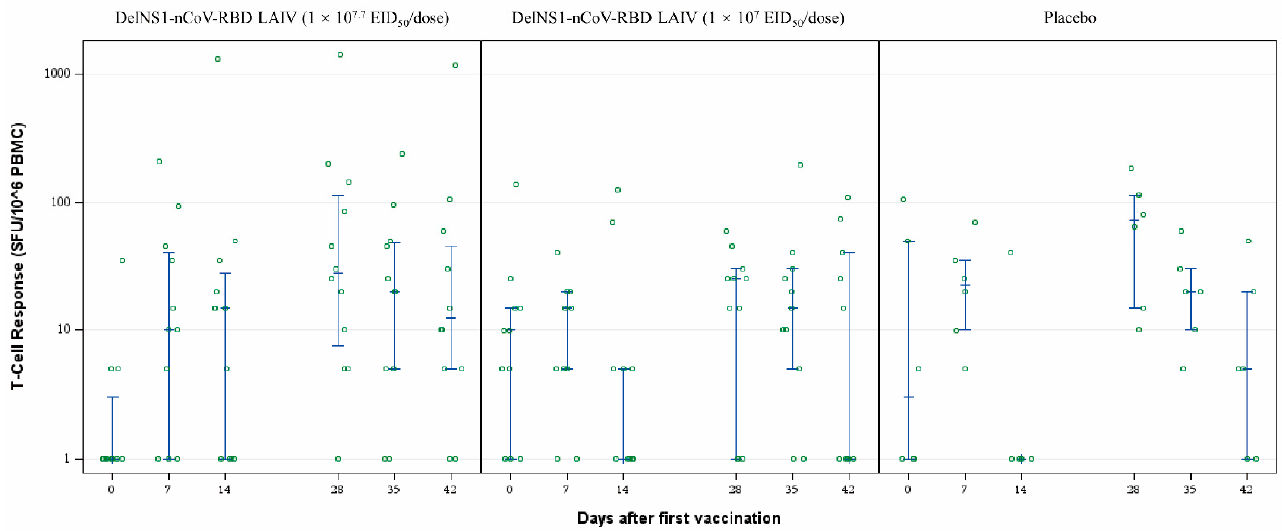
Figure 4. T-cell responses by ELISpot over time. Blood samples were taken from the subjects on baseline (day 0) and at 7, 14, 28, 35, and 42 days after the first dose of vaccine. Once separated from the blood, PBMC were seeded into anti-human IFN- γ antibody coated plate followed by the incubation with SARS-CoV-2 RBD peptide pool overnight. The substrate was added into the plate after cells incubated with Streptavidin-Alkaline Phosphatase (ALP). The spots in the plate were counted under an immunospot reader. One-way ANOVA was used to compare the T-cell response in the three groups. The error bars represent median with interquartile ranges (IQR) . Table 3. Summary of T-Cell ELISpot response.